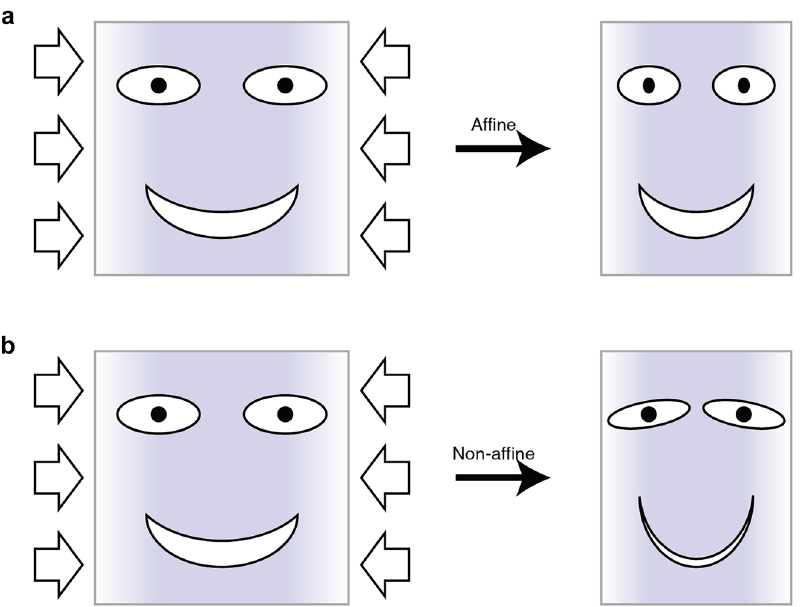
in the length dimension to another variable in the length dimension. The vectors normal vectors, i.e., used, the level-set surface of the triclinic gyroid can be placed on various orthonormal axes sets. Moreover, the lattice constant a is cancelled in case the above F is substituted into Eq. (35). Therefore, any positive value can be temporally used for a .